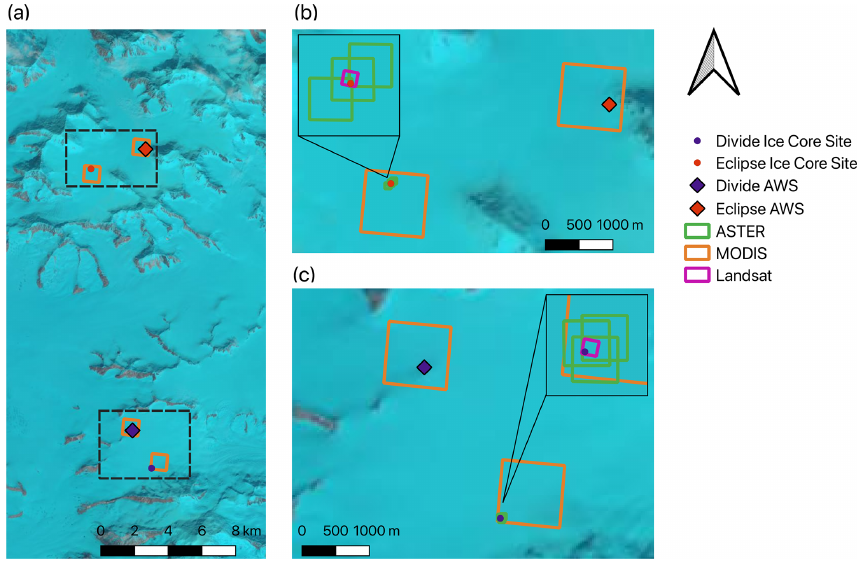
Figure 2. MODIS (orange box), ASTER (Advanced Spaceborne Thermal Emissions Radiometer; green box), and Landsat (pink box) foot- prints at the Eclipse and Divide ice core and AWS sites. (a) Upper Kaskawulsh–Donjek area containing the Eclipse and Divide sites. (b) Eclipse ice core (red dot) and AWS (red diamond) sites. (c) Divide ice core (blue dot) and AWS (blue diamond) sites. Dashed lines in panel (a) show the extents of panels (b) and (c) . Both the Divide AWS sensors (Campbell 107F and HOBO-S-THB-M008) were located at the Divide AWS site. Both the Eclipse AWS and iButton sensor were located at the Eclipse AWS site. Background imagery from Landsat 8 on 30 June